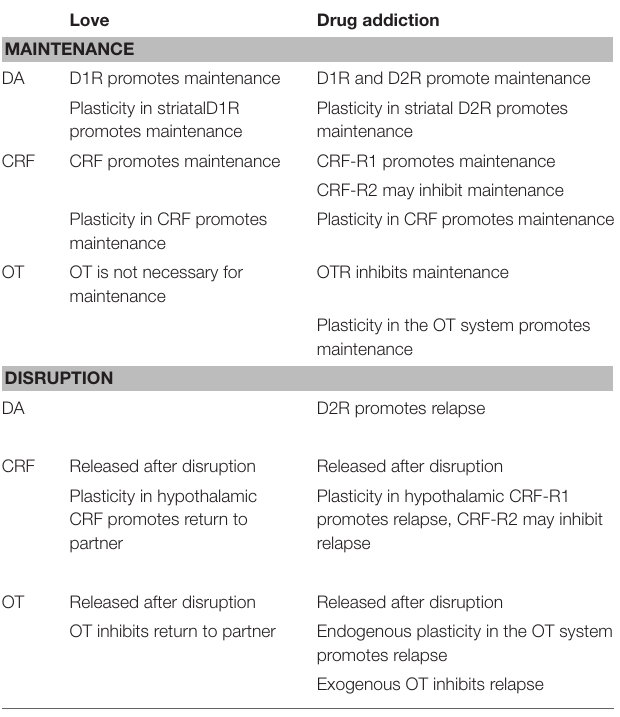
TABLE 2 | Function and alterations of neurochemical systems involved in love and